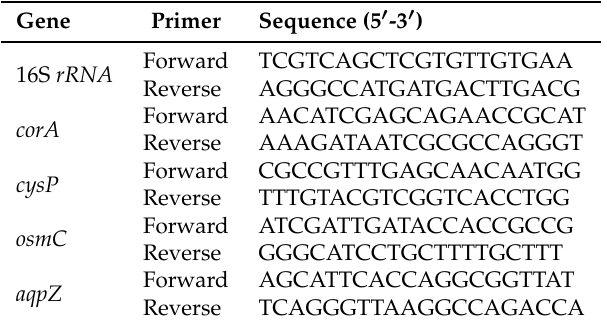
Table 1. List of the primers used.